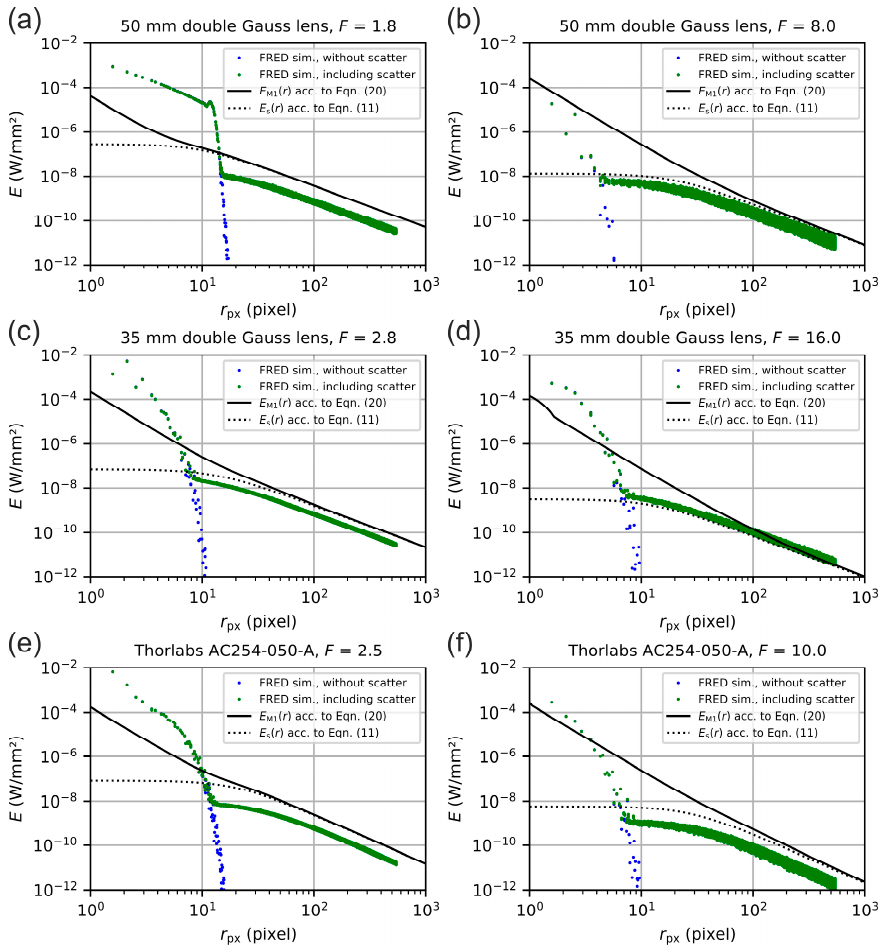
Figure 22. Modeling of the focal plane irradiance as a function of radial distance to the center of the laser spot for the following lens/f-number combinations: 50 mm double Gauss lens with 𝐹 = 1.8 ( a ) and 𝐹 = 8.0 ( b ); 35 mm double Gauss lens with 𝐹 = 2.8 ( c ) and 𝐹 = 16.0 ( d ) and achromatic doublet lens: 𝐹 = 2.5 ( e ) and 𝐹 = 10.0 ( f ).